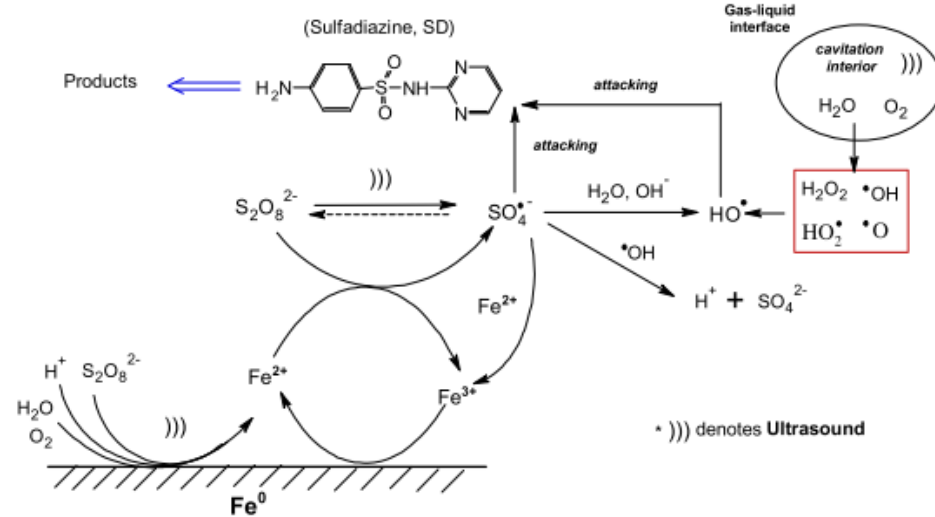
Figure 3. Molecules 2020 , 25 , x FOR PEER REVIEW